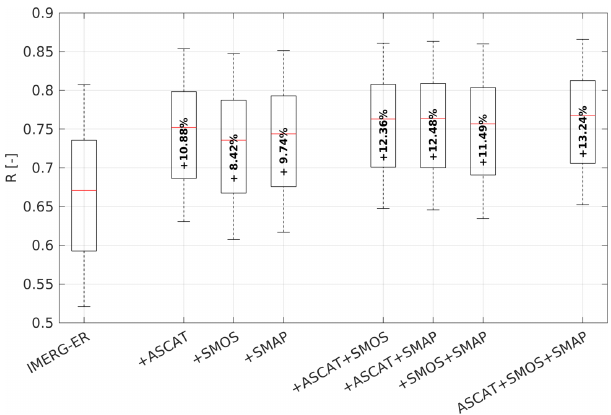
Figure 4. Correlation increments obtained by ingesting ASCAT, SMOS and SMAP SM2RAIN-based rainfall estimates into the IMERG-ER product. Values in bold inside the box plots refer to the median increments expressed in terms of percentage. The box plot refer to the 25th and 75th percentiles, while the whiskers refer to the minimum and maximum values. Outliers are not shown in the